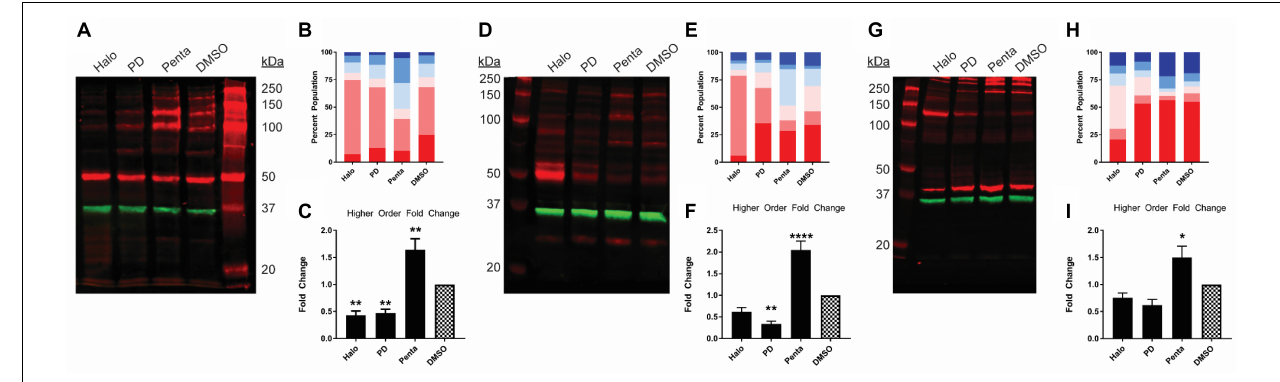
FIGURE 2 | Pharmacological effects on SDS-PAGE mobility among the unmodified and C-terminally tagged σ 1R constructs. Results for the unmodified (A–C) , C-terminally myc-tagged (D–F) , and C-terminally Nluc tagged (G–I) constructs are shown. (A , D , G) Red bands are visualized by anti- σ 1R (A,G) or anti-myc (D) antibodies and green bands are visualized by anti-GAPDH (A,D,G) antibodies on 10% SDS-PAGE (protein standard, haloperidol, PD 144418, (+)-pentazocine, DMSO vehicle). (B , E , H) Quantification of band intensities normalized to total signals within each lane for σ 1R (B,H) and myc (E) blots. (C , F , I) Pharmacological changes in higher order densities corresponding to tetramers, pentamers, and hexamers normalized to DMSO vehicle (haloperidol, PD 144418, (+)-pentazocine, DMSO vehicle). Each blot image is representative of n > 3 experiments that are averaged in bar graphs. One-way ANOVA followed by post hoc Tukey analysis ( ∗ p < 0.05, ∗∗ p < 0.01, and ∗∗∗∗ p <